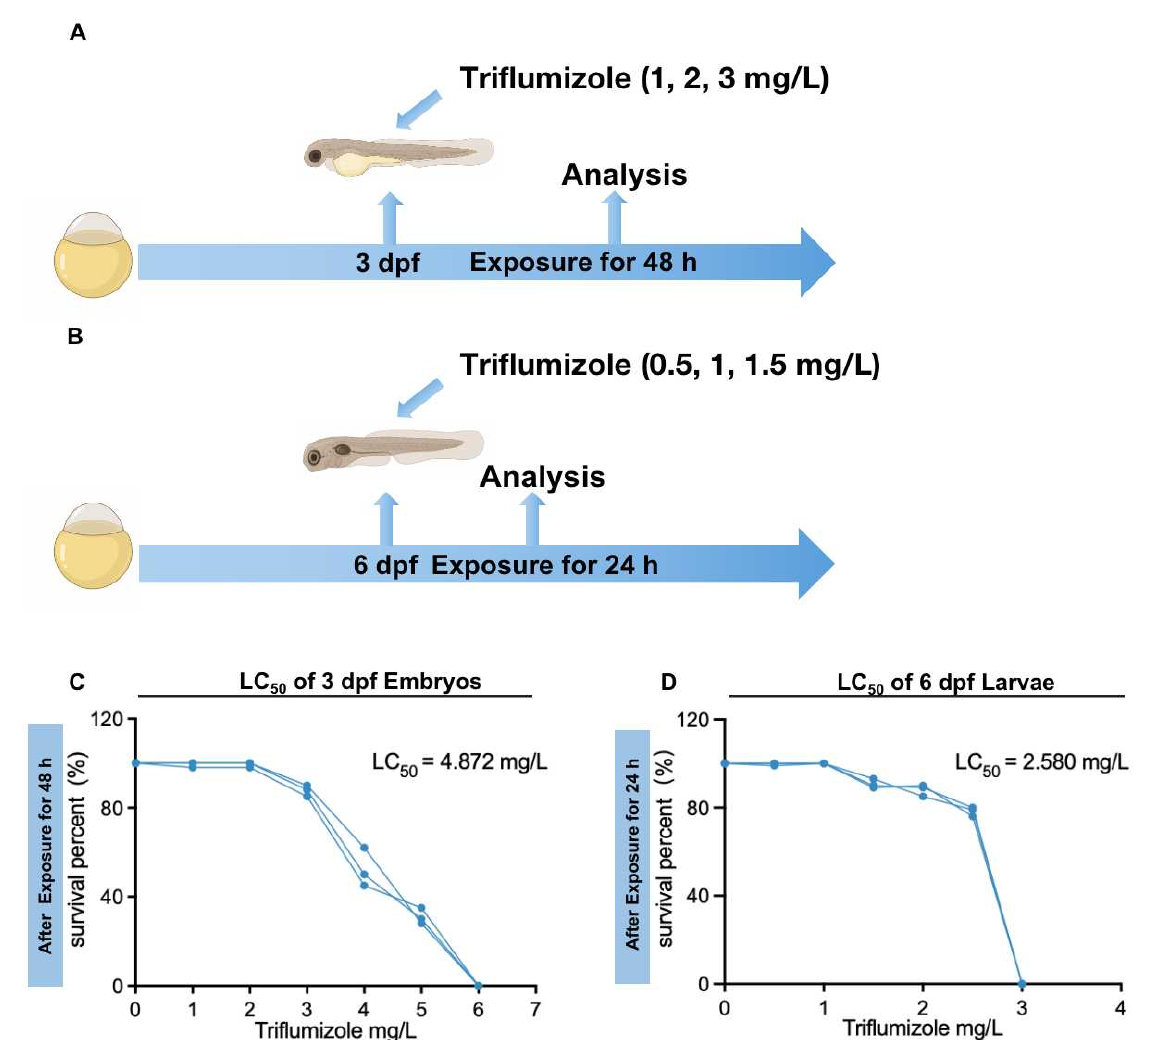
Figure 1. Exposure patterns and the survival percentage of zebrafish after triflumizole exposure. ( A ) Three dpf embryos were exposed to 1, 2, and 3 mg/L triflumizole for 48 h, ( B ) Six dpf larvae were exposed to 0.5, 1, and 1.5 mg/L triflumizole for 24 h. ( C ) The percentage of survival of 3 dpf embryos after triflumizole exposure for 48 h. ( D ) The percentage of survival of 6 dpf larvae after triflumizole exposure for 24 h. dpf: d post-fertilization; LC 50 : lethal concentration 50.